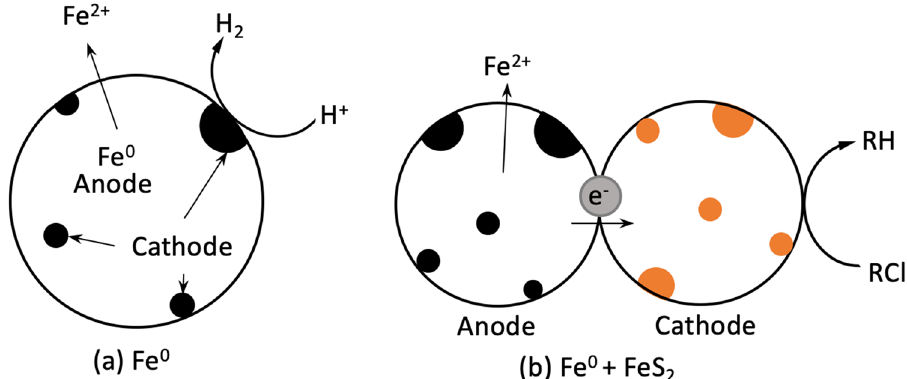
Figure 4. Schematic diagram of interactions between metallic iron (Fe 0 ), pyrite (FeS 2 ) and contaminants (RCl) in the remediation process: ( a ) Fe 0 /H 2 O and ( b ) Fe 0 /FeS 2 /H 2 O. In the Fe 0 /H 2 O system, anode and cathode are different sites on the same grain. In the Fe 0 /FeS 2 /H 2 O system, granular Fe 0 is additionally the anode and FeS 2 the cathode. The representation is based on the knowledge that Fe 0 is not a reducing agent. Therefore, electrochemical contaminant reduction of RCl is possible in ( a ) and not in ( b